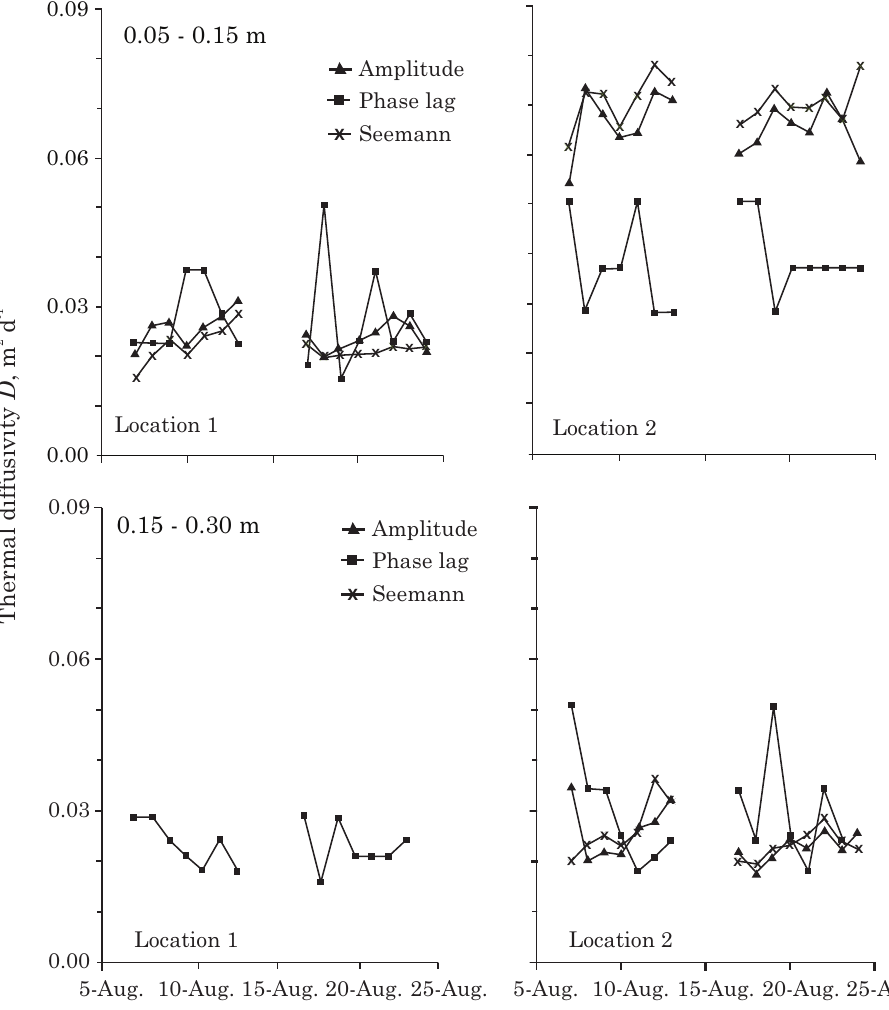
Figure 2. Thermal diffusivity D determined by the amplitude ratio method (Equation 12), the phase lag method (Equation 14) and the Seemann method (Equation 15) as a function of time (dates refer to 2010) for both Locations and both depth